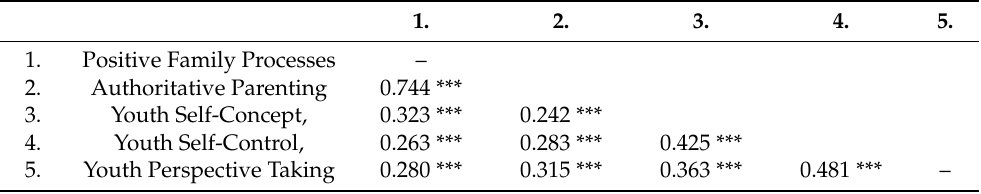
Table 2. Adjusted Correlations of Positive Family Processes, Authoritative Parenting, Youth Self- Concept, Self-Control, and Perspective